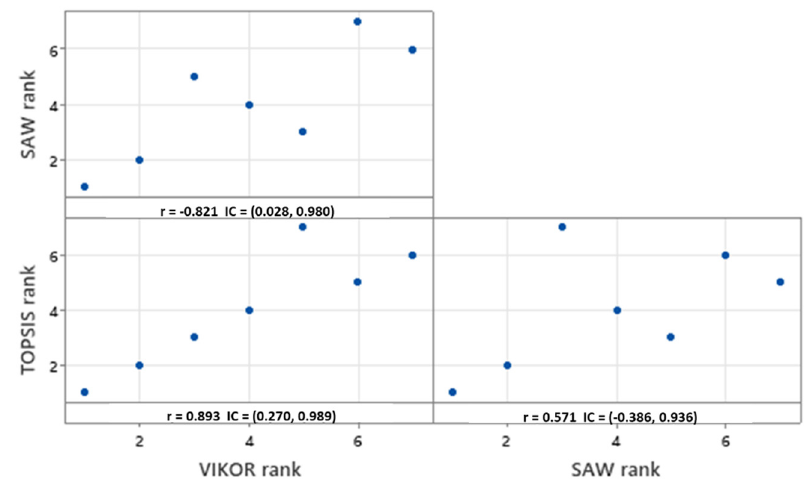
Figure 8. Spearman rank correlation results (confidence interval = 95.0%).